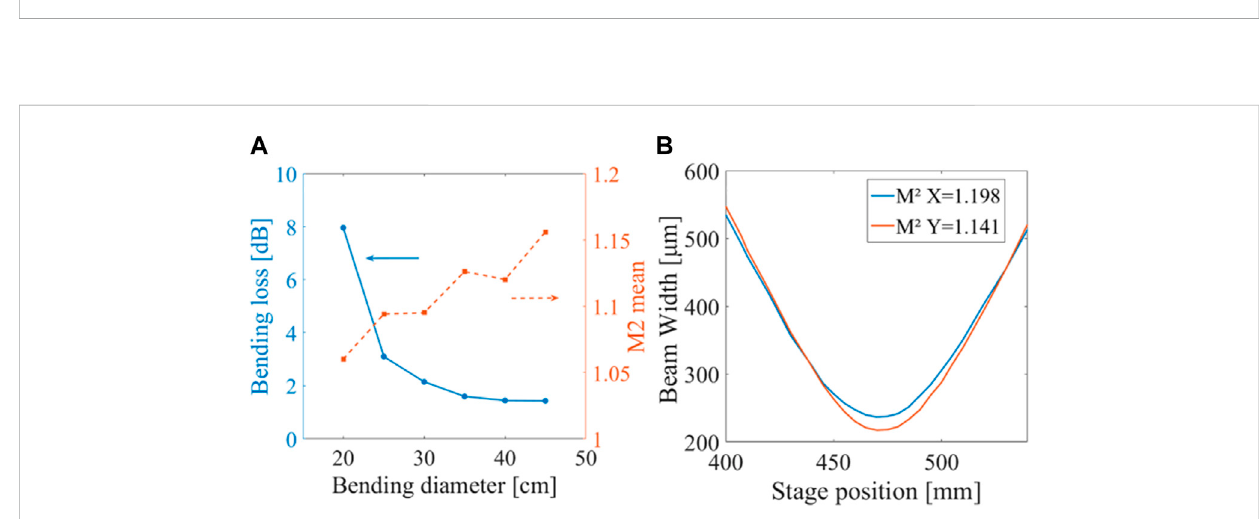
FIGURE 5 (A) Measured 6.1 W-output laser (input laser 10 W) transmission spectra after the vacuum-pumped AR-HCF. The curves from bottom to top show the spectral pro fi les that obtained under chamber pressure from p = 0.2 atm (blue curve), 0.4 atm (orange curve), 0.6 atm (yellow curve), and 1 atm (purple curve), respectively. (B) Autocorrelation curves under different